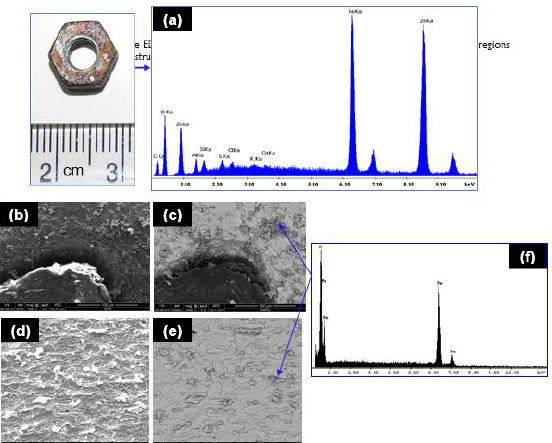
Figure 18: (a) EDS analysis result for the corrosion debris on the as-received nut, (b,c) scanning electron micrographs along the threaded region under respective SE and BSE modes showing presence of corrosion products, (d,e) scanning electron micrographs away from the threaded region and deep into the structure under respective SE and BSE modes showing presence of corrosion products, (f) EDS analysis results for the corrosion products.